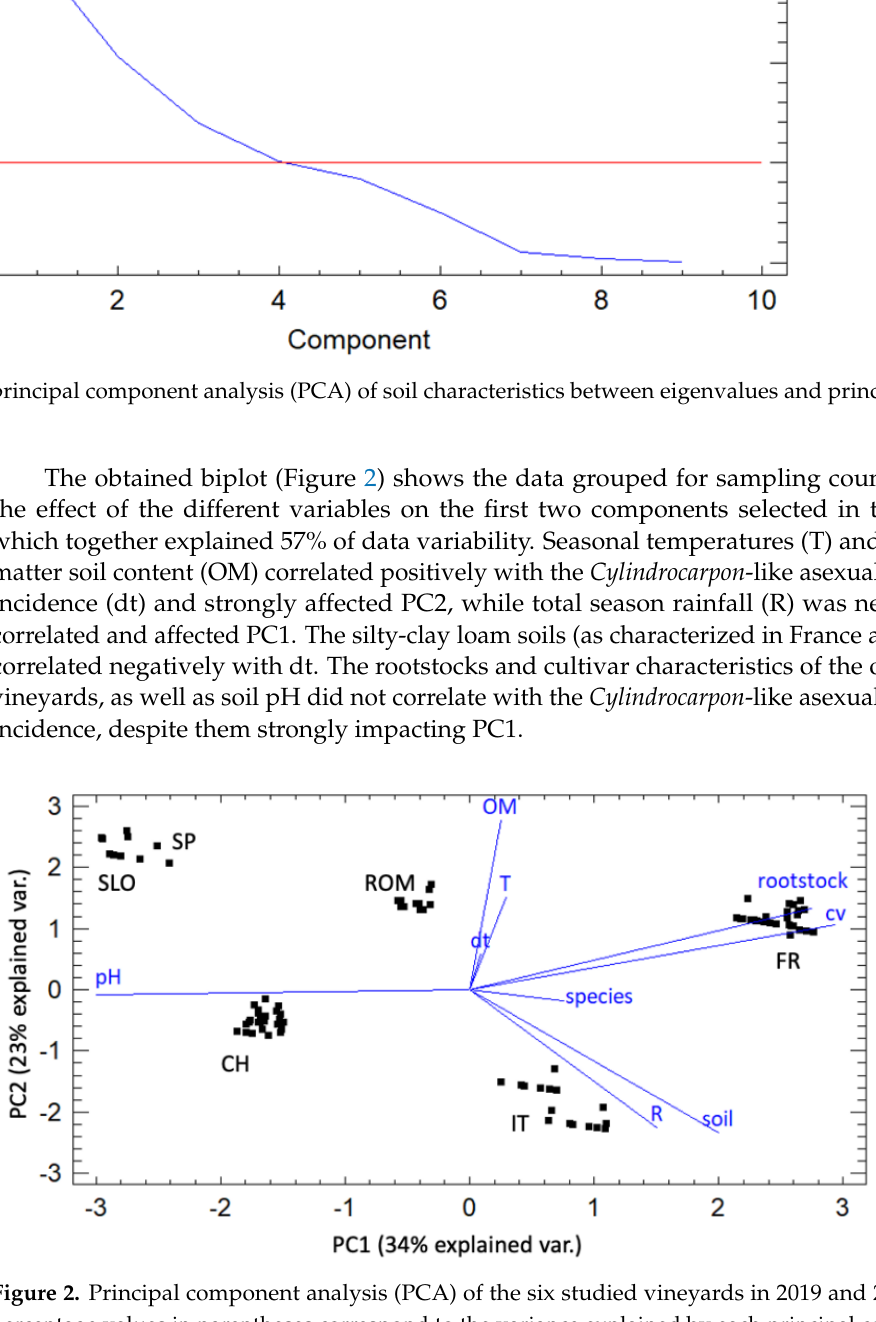
Figure 2. Principal component analysis (PCA) of the six studied vineyards in 2019 and 2020. The percentage values in parentheses correspond to the variance explained by each principal component (dt = Cylindrocarpon -like asexual morphs incidence; OM = organic matter soil content; R = total season rainfall; T = seasonal temperatures).